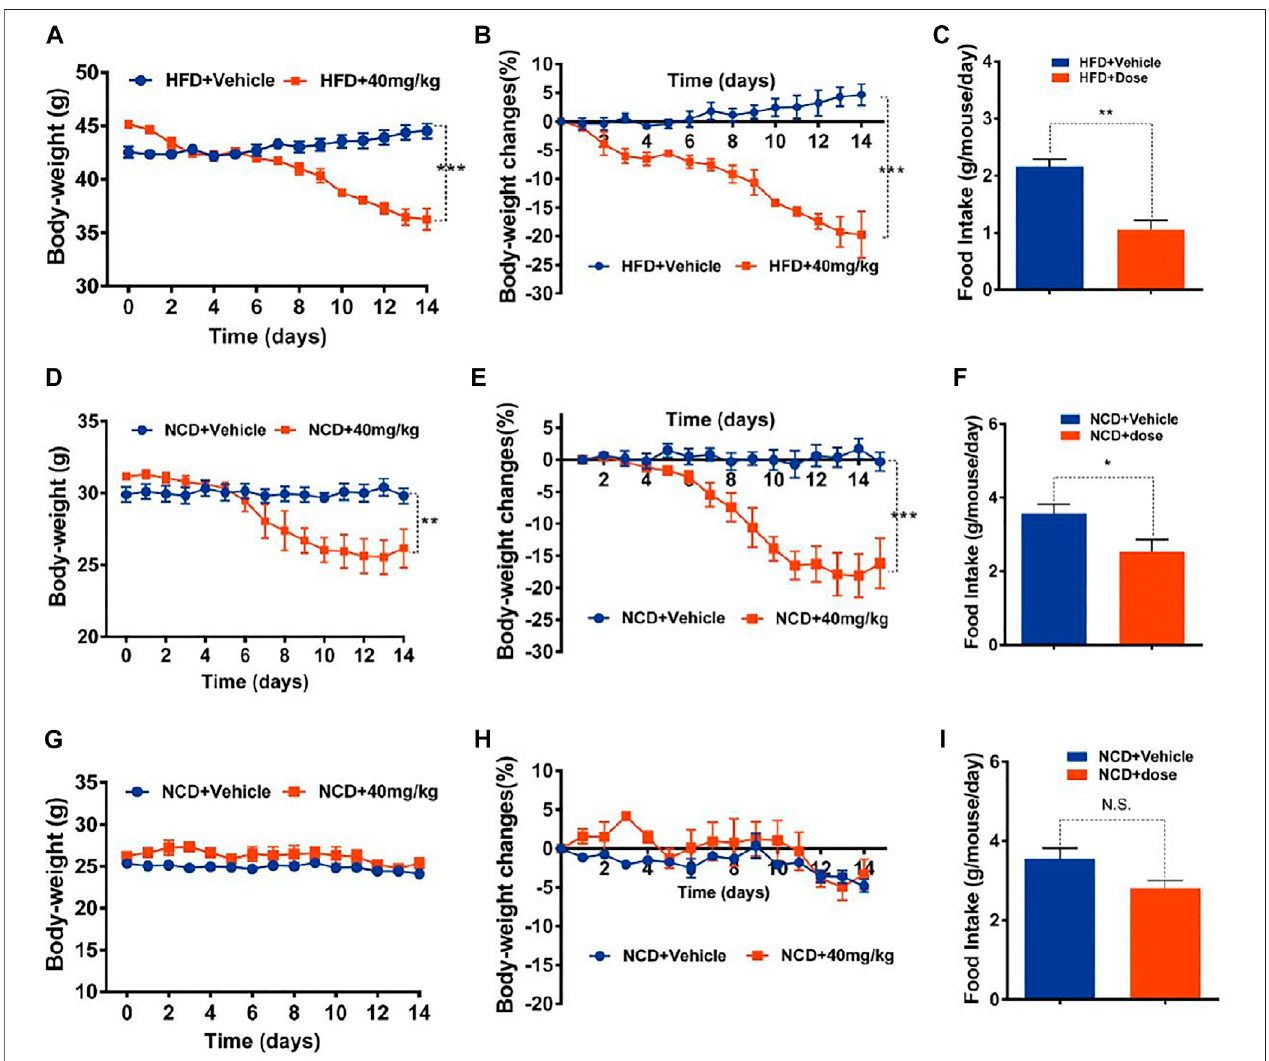
FIGURE 4 | Oral treatment of mice with GA-02. (A – C) DIO mice, (D – F) old lean mice, (G – I) lean mice were orally administered vehicle (PBS, pH (cid:2) 9) or GA-02 (40 mg/kg;o.a.)for2 weeks. (A) Bodyweightand (B) percentdecrease(%)inbodyweightofDIOmiceduringthetreatment. (C) Theaveragefoodintake (G) ofDIOmice duringthetreatment( n (cid:2) 5forvehiclegroupand n (cid:2) 5forGA-02groupin A – C ). (D) Bodyweightand (E) percentdecrease(%)inbodyweightofoldleanmiceduringGA- 02treatment; (F) Theaveragesfoodintakeoftheoldleanmiceduringthetreatment.( n (cid:2) 6forvehiclegroupand n (cid:2) 6forGA-02groupin D – F ). (G) Bodyweightand (H) percent decrease (%) in body weight of lean mice during GA-02 treatment; (I) The average food intakes of lean mice during the treatment. n (cid:2) 6 for each group in (G – I) . Error bars are represented as mean ± SEM. (* p < 0.05, ** p < 0.01, *** p < 0.001).